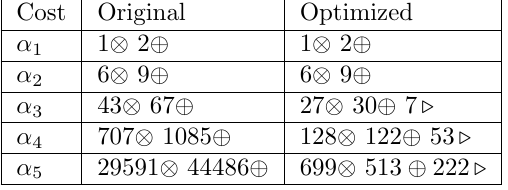
Table 3: Cost of calculation in number of multiplication ( ⊗ ), number of additions ( ⊕ ) and number of assignments ( (cid:46) ) for each stabilizing function α i . Last column is the cost when the calcula- tions are